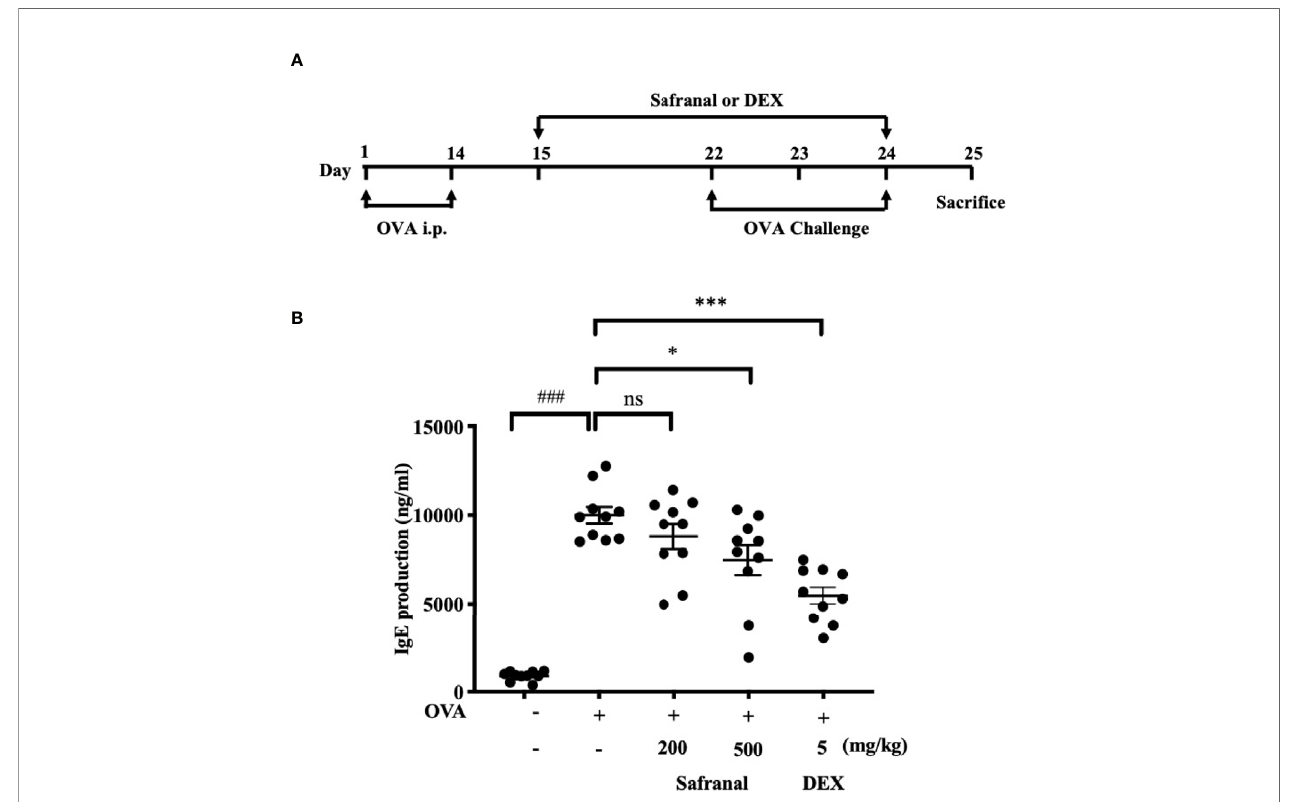
FIGURE 1 | Safranal alleviates OVA-induced asthma. (A) OVA-induced asthma model. Mice were sensitized with OVA on days 1 and 14 before oral administration of vehicle, Safranal or Dexamethasone. On days 22, 23, and 24 Mice were challenged with OVA. Blood samples were collected by cardiac puncture and level of serum IgE was determined (B) . The data are presented as the means ± S.E.M. of n=10. Ns=no signi fi cance ### p < 0.001 compared to nontreated group, * p < 0.05, *** p < 0.001 compared to OVA treated